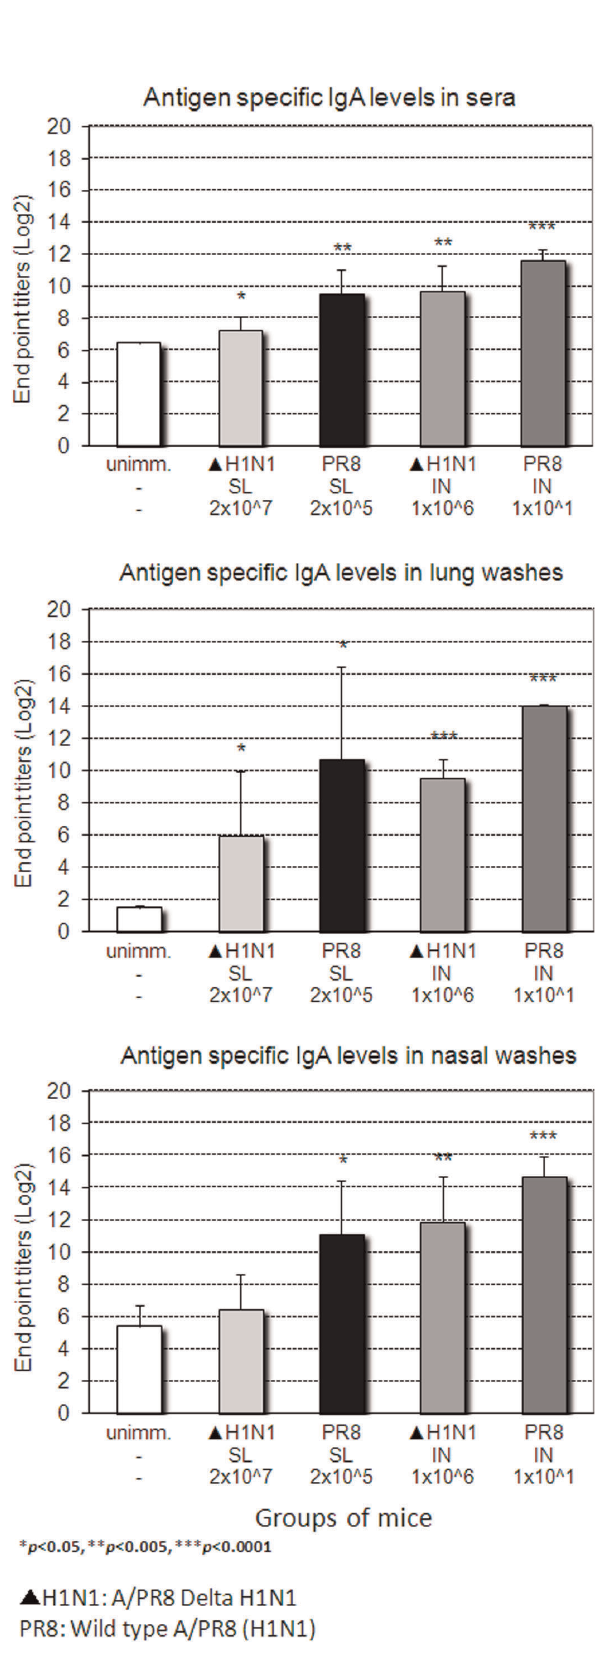
Figure 7. Levels of virus-specific IgA induced in mucosal and systemic compartments upon immunization with DeltaNS1 IAV. BALB/c mice were immunized as described in Figure 6. Four weeks later, titers of H1N1 (A/PR8) virus-specific IgA in sera and secretions